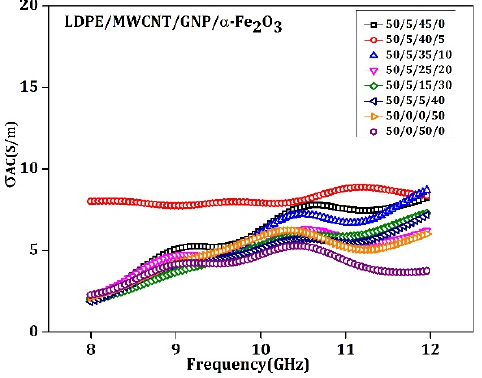
Figure 12. The conductivity versus frequency for the 3.5 mm thick LDPE: MWCNT: GNP: α -Fe 2 O 3 matrix specimen.